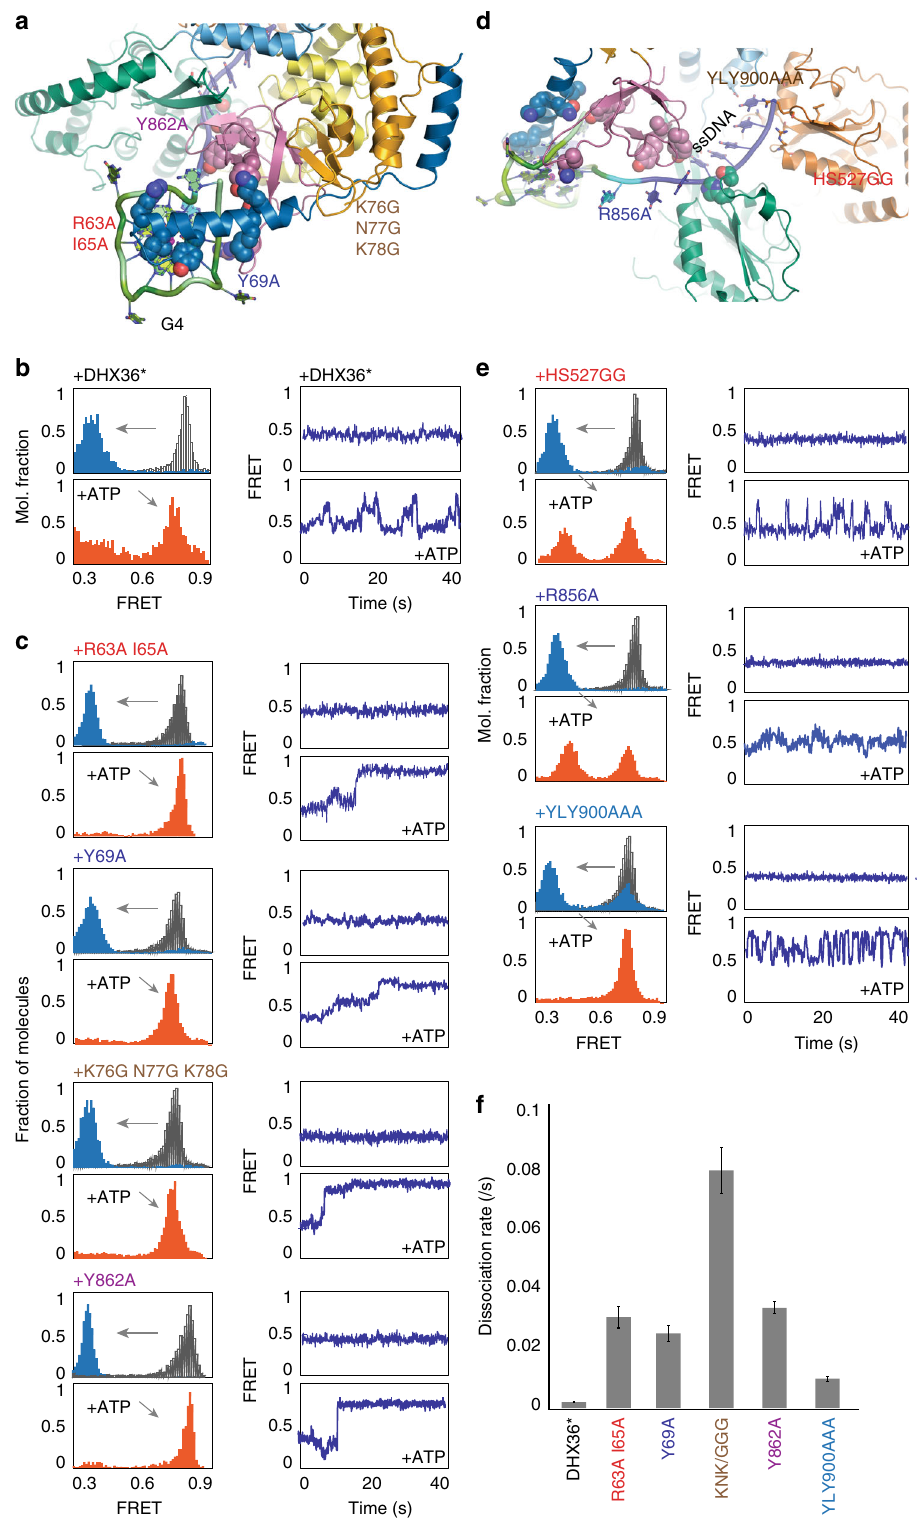
Fig. 5 Point mutations reveal a clear partition in DHX36 function. a Site-directed mutations introduced to DHX36 G4 acting elements. b Histogram and smFRET traces obtained for DHX36*, a bovine version used in previous structural study. c Histograms and smFRET traces generated for all four mutants. They all bind G4-RNA stably, but exhibited fast dissociation upon ATP hydrolysis. d Biochemical mutations introduced to ssDNA interaction domain of DHX36. e Histogram and smFRET traces obtained for HS527GG (top), R856A (middle) and YLY900AAA (bottom). f Dissociation rate of DHX36 mutants upon ATP hydrolysis. The standard error bars were generated from over 200 molecules collected from three sets of experiments for each